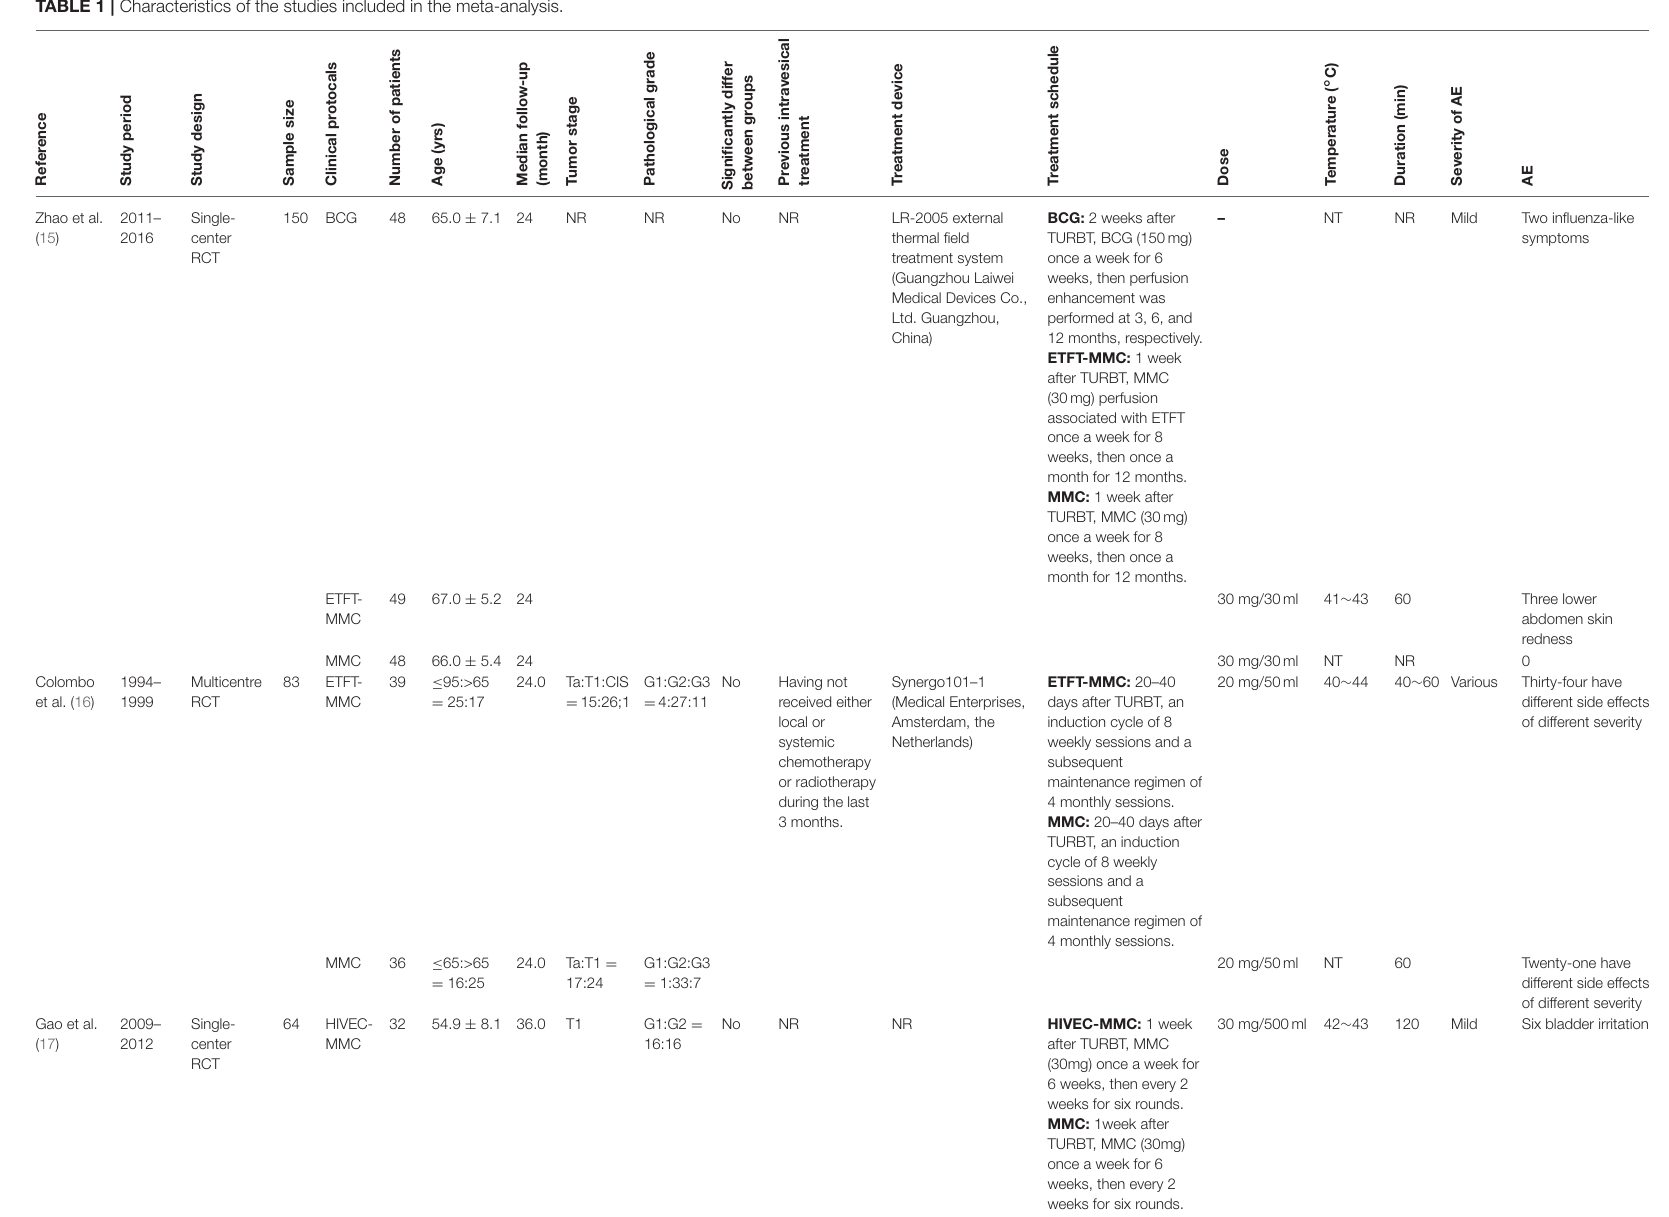
TABLE 1 | Characteristics of the studies included in the